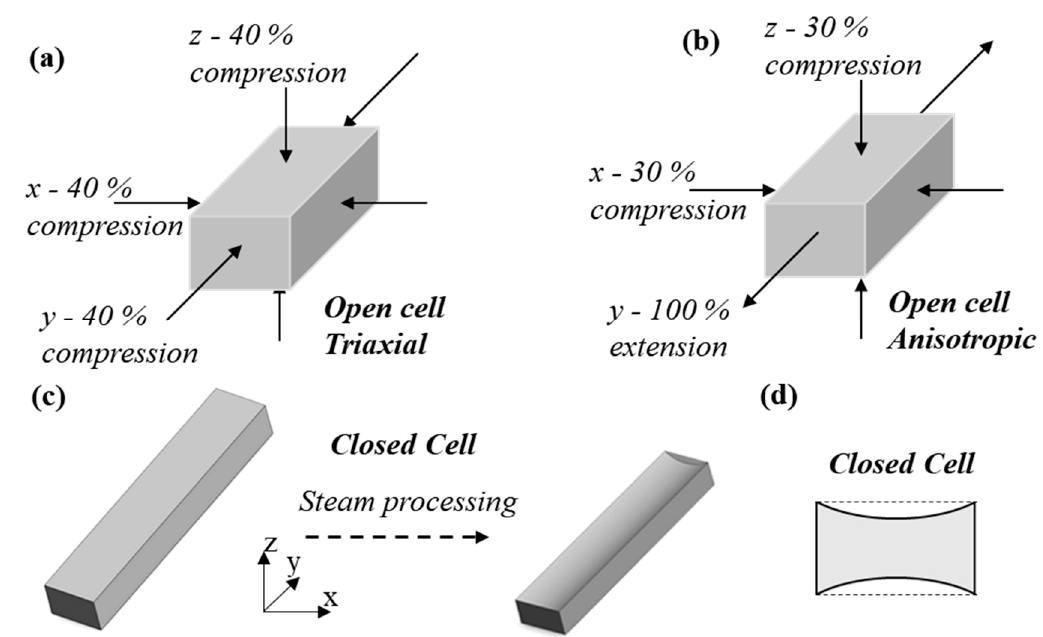
Figure 1. ( a,b ) Compression regimes for open cell foam fabricated with ( a ) triaxial and ( b ) anisotropic compression. ( c,d ) Closed cell foam ( c ) fabrication by steam processing and ( d ) imparted concave cross-section.